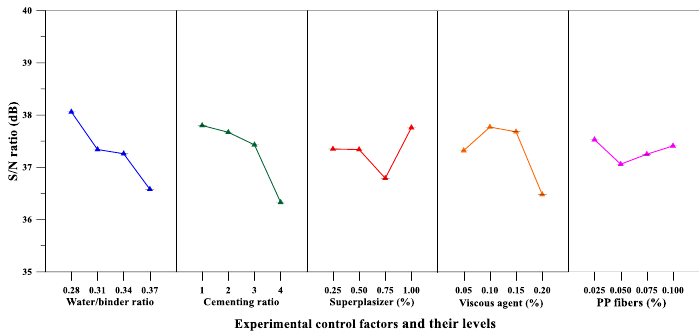
Figure 7. S / N response graph showing the compressive strength of the matrixes.